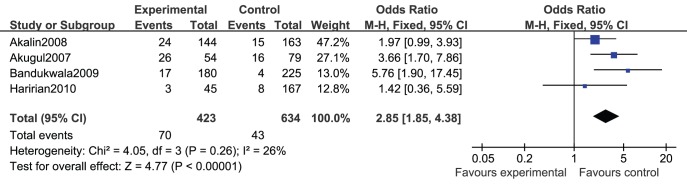
Relative risk of hyperuricemia with chronic allograft nephropathy.